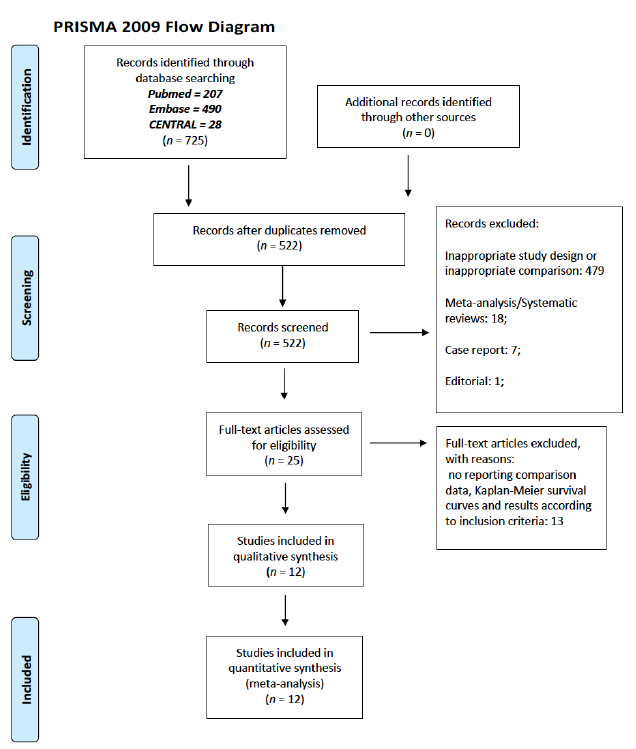
Figure 1. PRISMA flow chart.